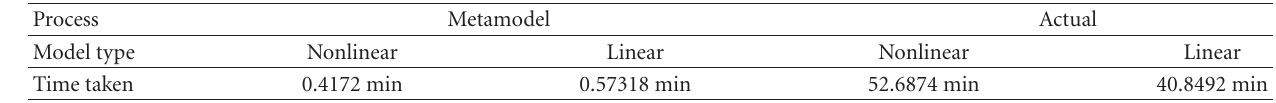
Table 4: Simulated time for tuning process.